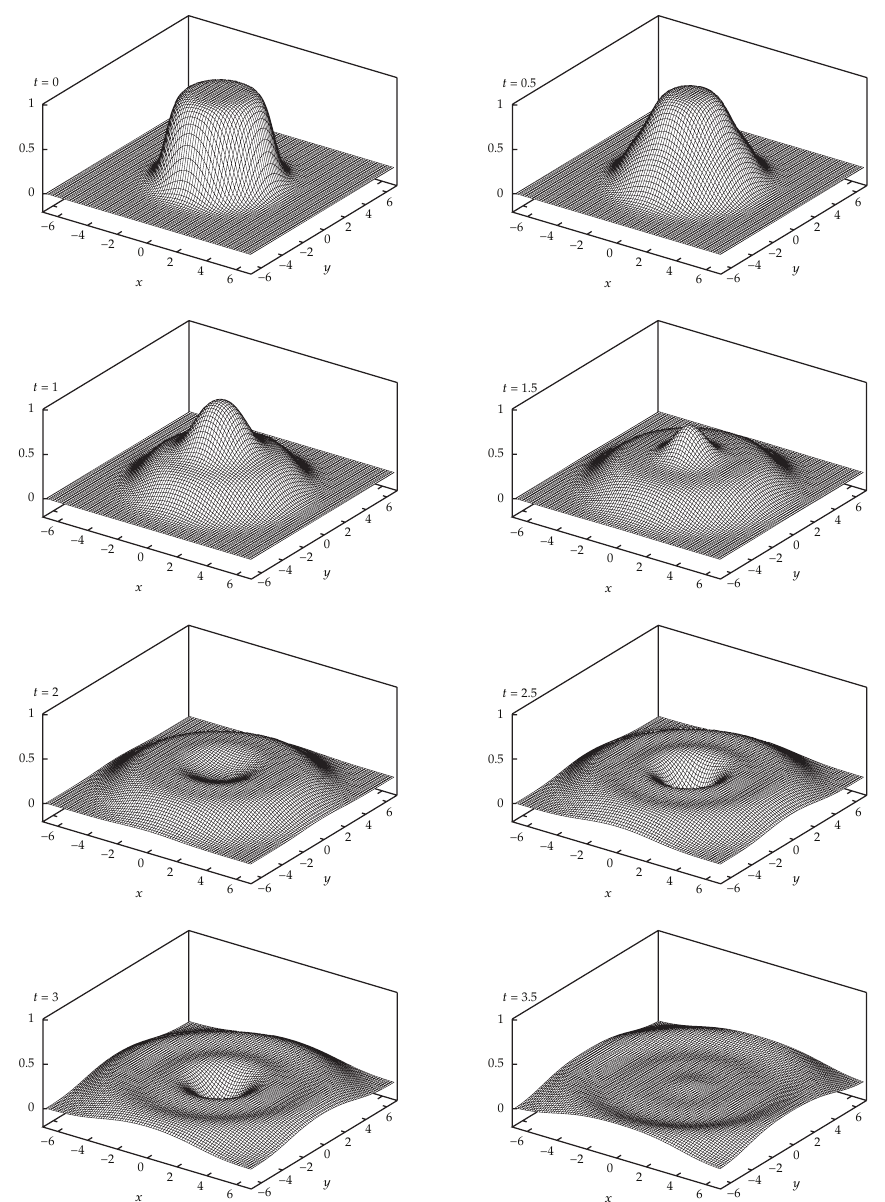
Figure 4: Numerical solution to (cid:4) 1.1 (cid:5) for α (cid:2) 1 . 5, t ∈ (cid:6) 0 , 3 . 5 (cid:7) , k (cid:4) t (cid:5) (cid:2) cos (cid:4) t (cid:5) , b ≡ 0. Periodic boundary